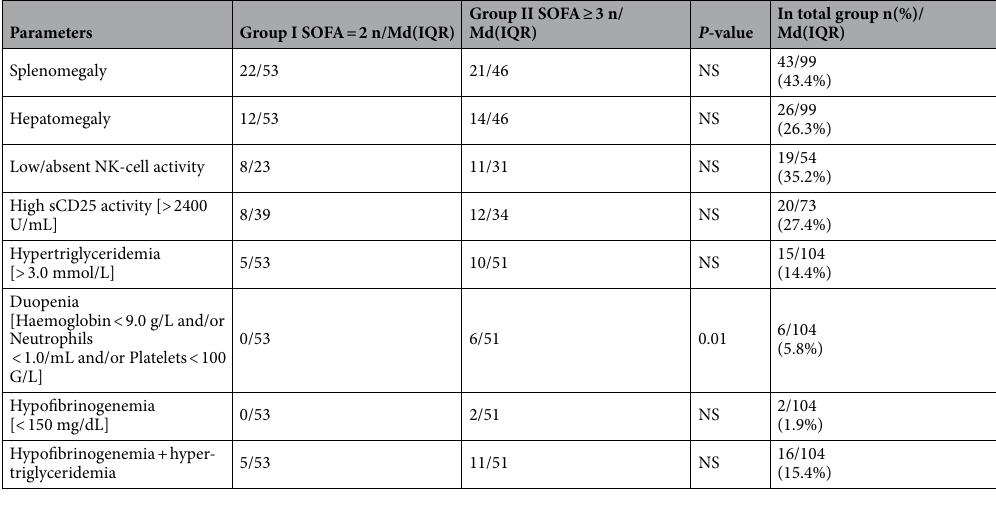
Table 3. General characteristics and HLH features presentation in the studied group (n = 104, Chi2 test, Mann–Whitney U test ). N, number of patients; NS, not statistically significant; SHLS, sepsis with HLH like syndrome; HLH, Hemophagocytic lymphohistiocytosis; MSSA, methicillin-sensitive Staphylococcus aureus ; MRSA, Methicillin-resistant Staphylococcus aureus ; sCD25, Soluble CD25; CMV, Cytomegalovirus; HIV, Human immunodeficiency